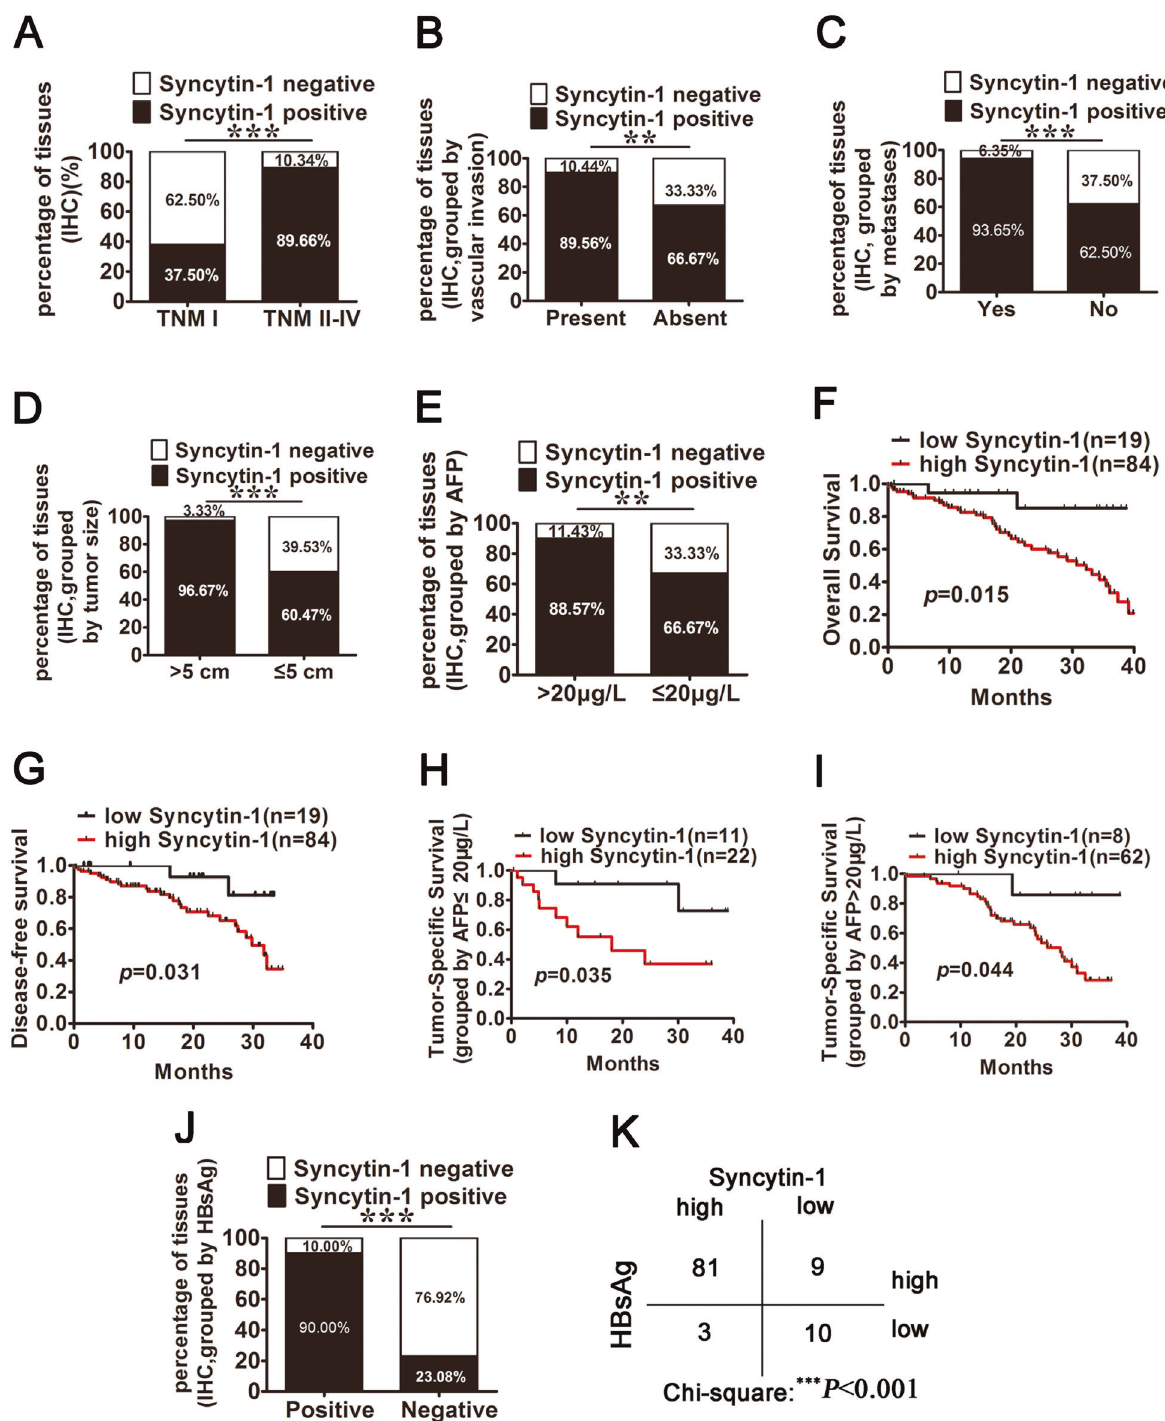
Fig. 2 High expression of Syncytin-1 protein predicts advanced HCC and poor prognosis. The IHC data of Syncytin-1 expression were reanalyzed. a The expression of Syncytin-1 was analyzed in four stages of HCC tissues. b – e The positivity rate of Syncytin-1 expression in HCC with vascular invasion ( b ), metastases ( c ), different tumor sizes ( d ), and serum level of AFP ( e ) were analyzed. f – i Syncytin-1 overexpression was positively correlated with poor overall survival ( f ) and poor disease-free survival ( g ). HCC with high Syncytin-1 expression had a lower median overall survival than HCC without the Syncytin-1 overexpression, regardless of the absence ( h ) or presence ( i ) of high serum AFP. j and k The overexpression of Syncytin-1 was positive in correlation with serum HBsAg positivity. * p < 0.05, ** p < 0.01, *** p < 0.001. The metastatic potential of Syncytin-1 was determined by numbers of S and G2/M stages in both NIH3T3 and HCCLM3 cells wound healing assay and transwell. The results of the wound ( p < 0.01, Fig. 3b, Supplementary Fig. S1b). These results healing assay demonstrated that Syncytin-1 improved the suggested that Syncytin-1 could promote proliferation and cell mobility of NIH3T3 cells compared to control ( p < 0.01, Fig. 3c). cycle progression in HCC cells. Cell Death Discovery (2021)